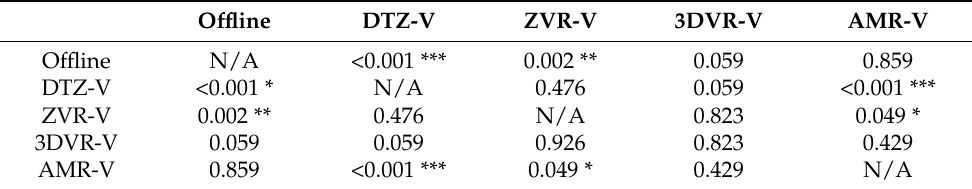
Table A4. Social Presence post hoc—Tukey HSD (Statiscally significance levels: * p < 0.05; ** p <